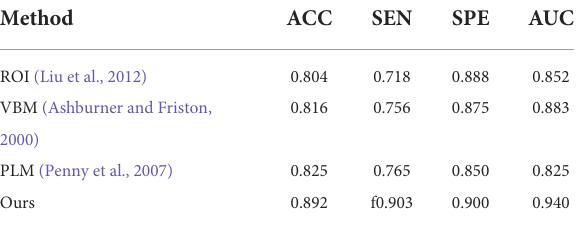
TABLE 5 Comparison of our method with previous machine learning studies (AD progression detection based on the AIBL dataset).